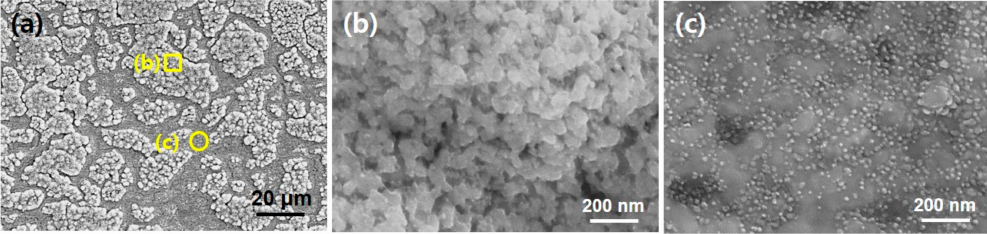
Figure 2. ( a ) Large area SEM view of Inconel 600 substrate surface after air-annealing and plasma pretreatment; ( b ) and ( c ) are high magnification SEM images showing morphologic di ff erence between